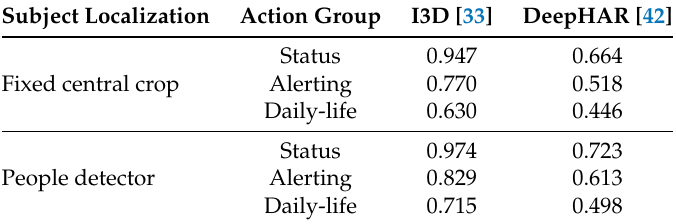
Table 7. Results of average per-class accuracy for compared architectures. We conduct experiments with fixed central crop and with the use of people detector for both selected